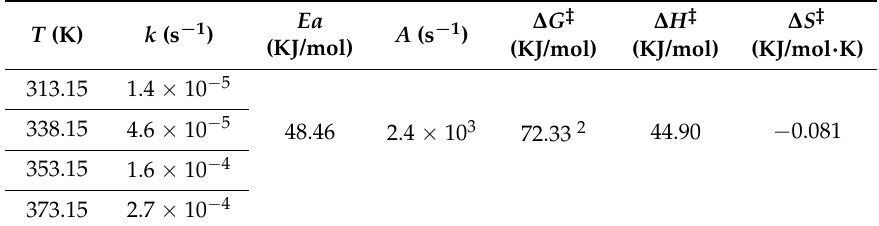
Table 1. Kinetic ( Ea ) and thermodynamic parameters of activation ( ∆ G ‡ and ∆ H ‡ ) for ZnO/TBAI catalyzed methanol transesterification reaction of soybean oil 1